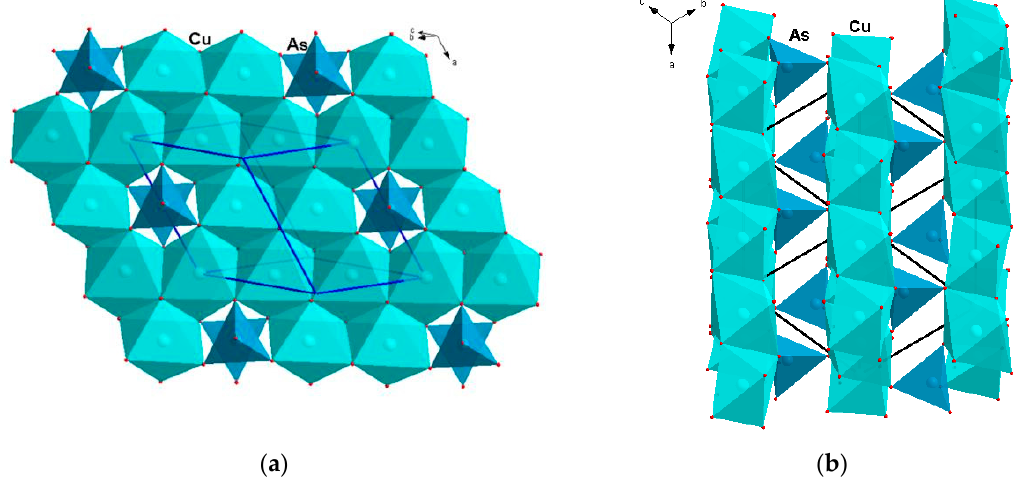
Figure 2. The crystal structure of cornubite, Cu 5 (OH) 4 [AsO 4 ] 2 in projections along the [011] ( a ) and [111] ( b ) directions.